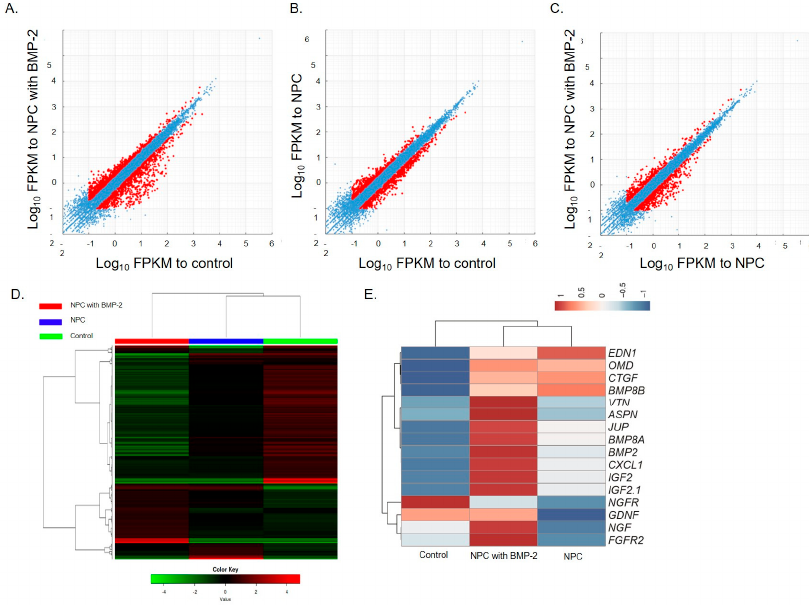
Figure 6. RNA-Sequence global reports. Scatter plots comparing gene expression patterns between NPC with BMP-2, NPC, and control ( A – C ). Heat map showing clustering of the 1000 most variable genes expressed in all samples ( D ). Each column represents one sample, and each row represents one gene. Hierarchical clustering was illustrated using the average linkage method with correlation distance. Color coding is based on empirical analysis of digital gene expression data in R (edgeR) log-transformed read count values. The color key indicates Z-scores that display the relative values of all tiles within all samples; green indicates lowest expression, black indicates intermediate expression, and red indicates highest expression. Heat map of key transcripts related to the osteo / dentinogenic di ff erentiation process ( E ). Fragments per kilobase of gene per million reads (FPKM) values were used for heatmap visualization. FPKM values were collected from genes involved in the osteo / dentinogenic di ff erentiation process. The heatmap was visualized by use of the web tool ClustVis (http: // biit.cs.ut.ee / clustvis / ) with default parameters. Red and blue indicate induced and repressed genes,